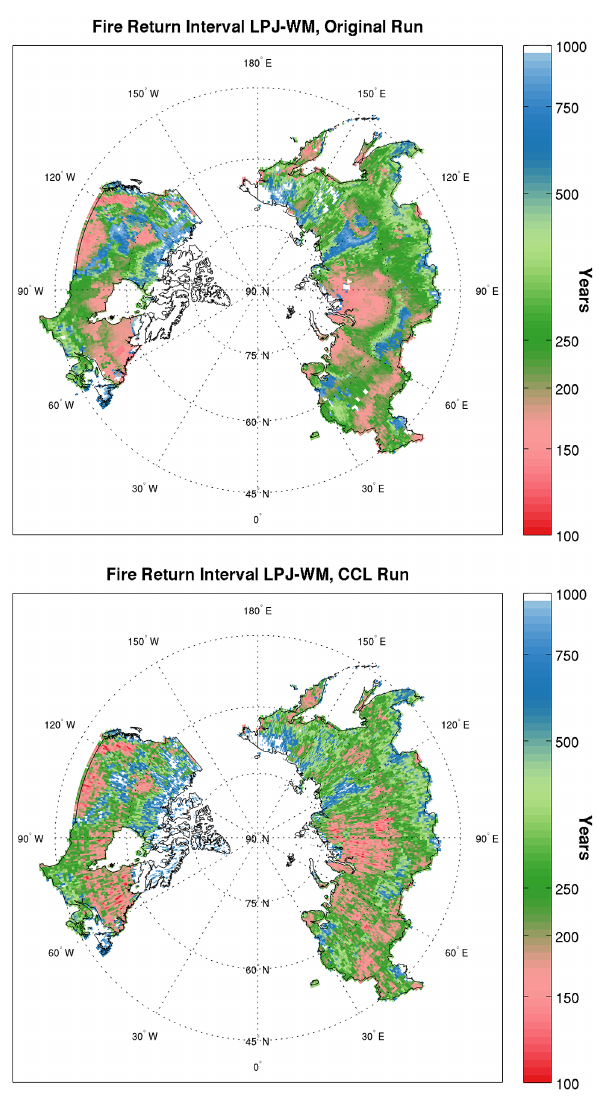
Figure 3. (top) Fire return interval produced by an original LPJ- WM run over a 1000years spin-up combined with a transient run (1901–2012) for Canada and Russia. (bottom) FRI produced by a LPJ-WM run over the same period with the CCL